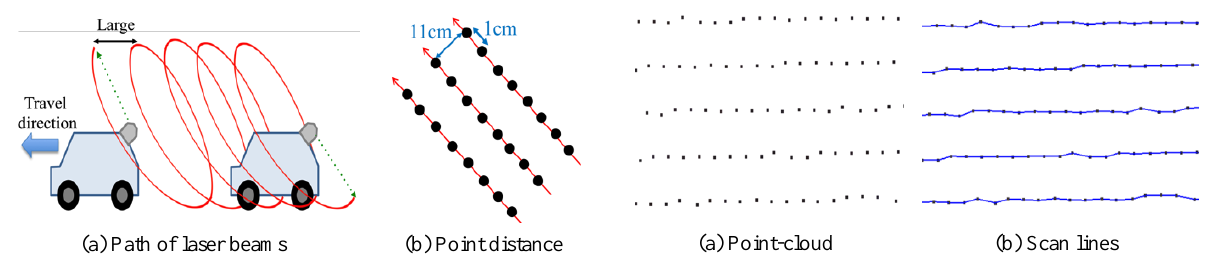
Figure 5. Scan lines of points